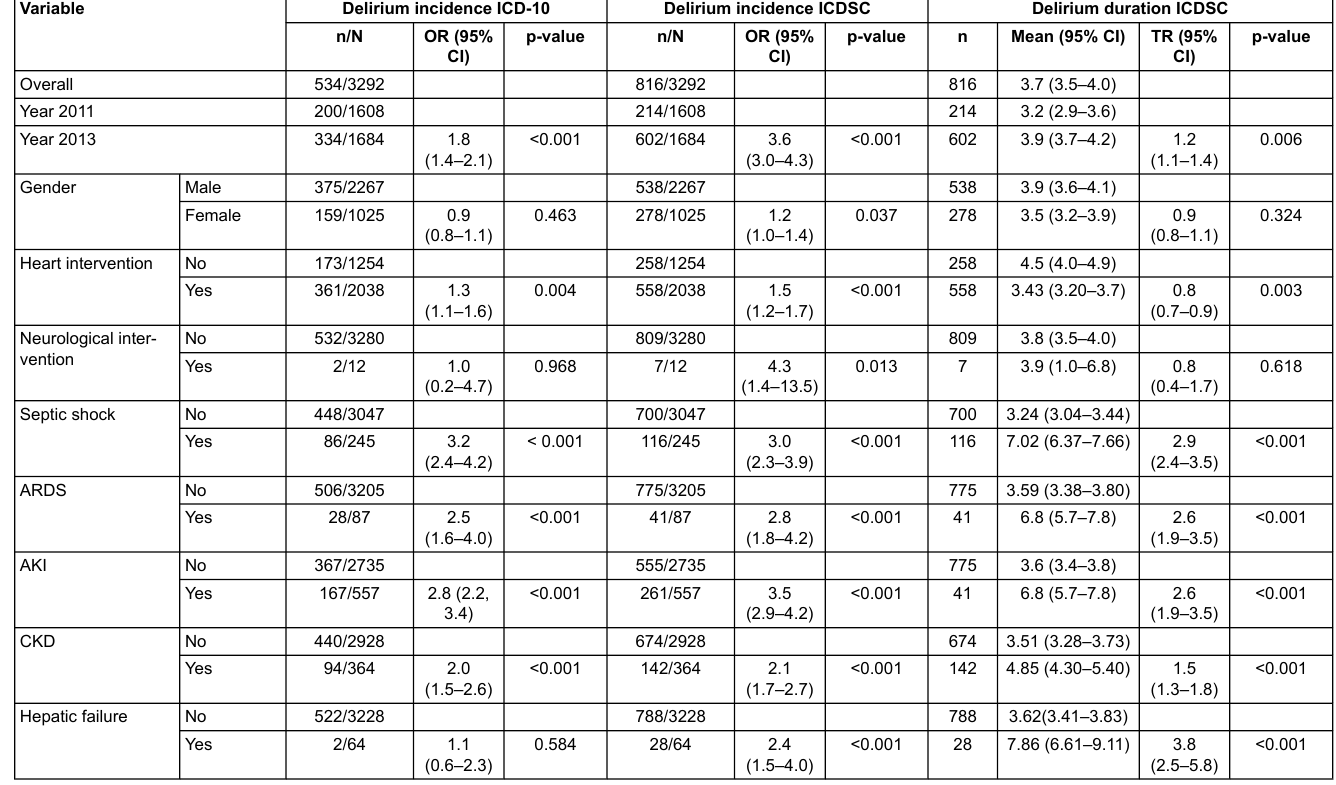
Table 2: Crude odds ratios for delirium incidence based on ICD-10 or ICDSC, and delirium duration.